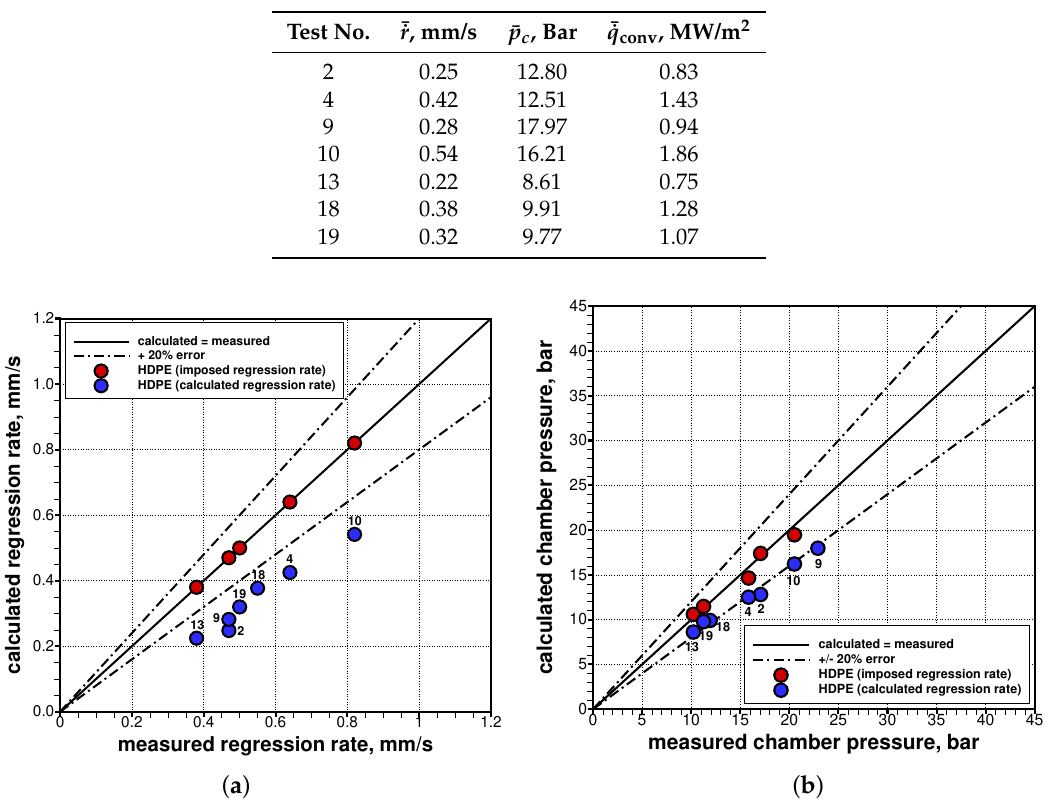
Table 11. Computed average results (gas–surface interaction w/o radiation).